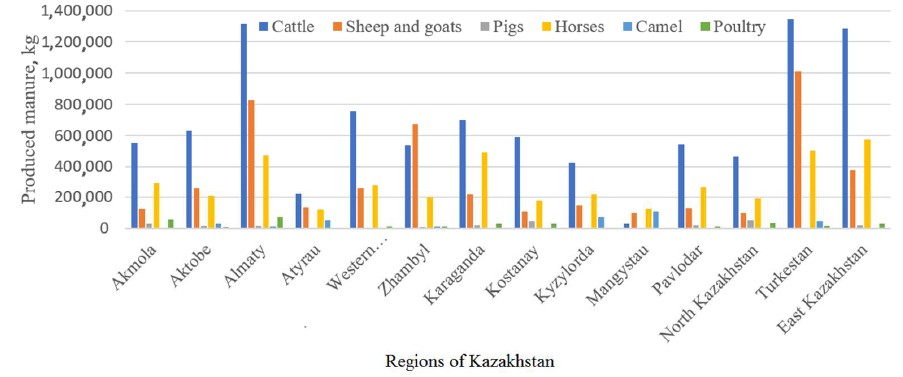
Figure 4. Produced manure in Kazakhstan by region in 2019.